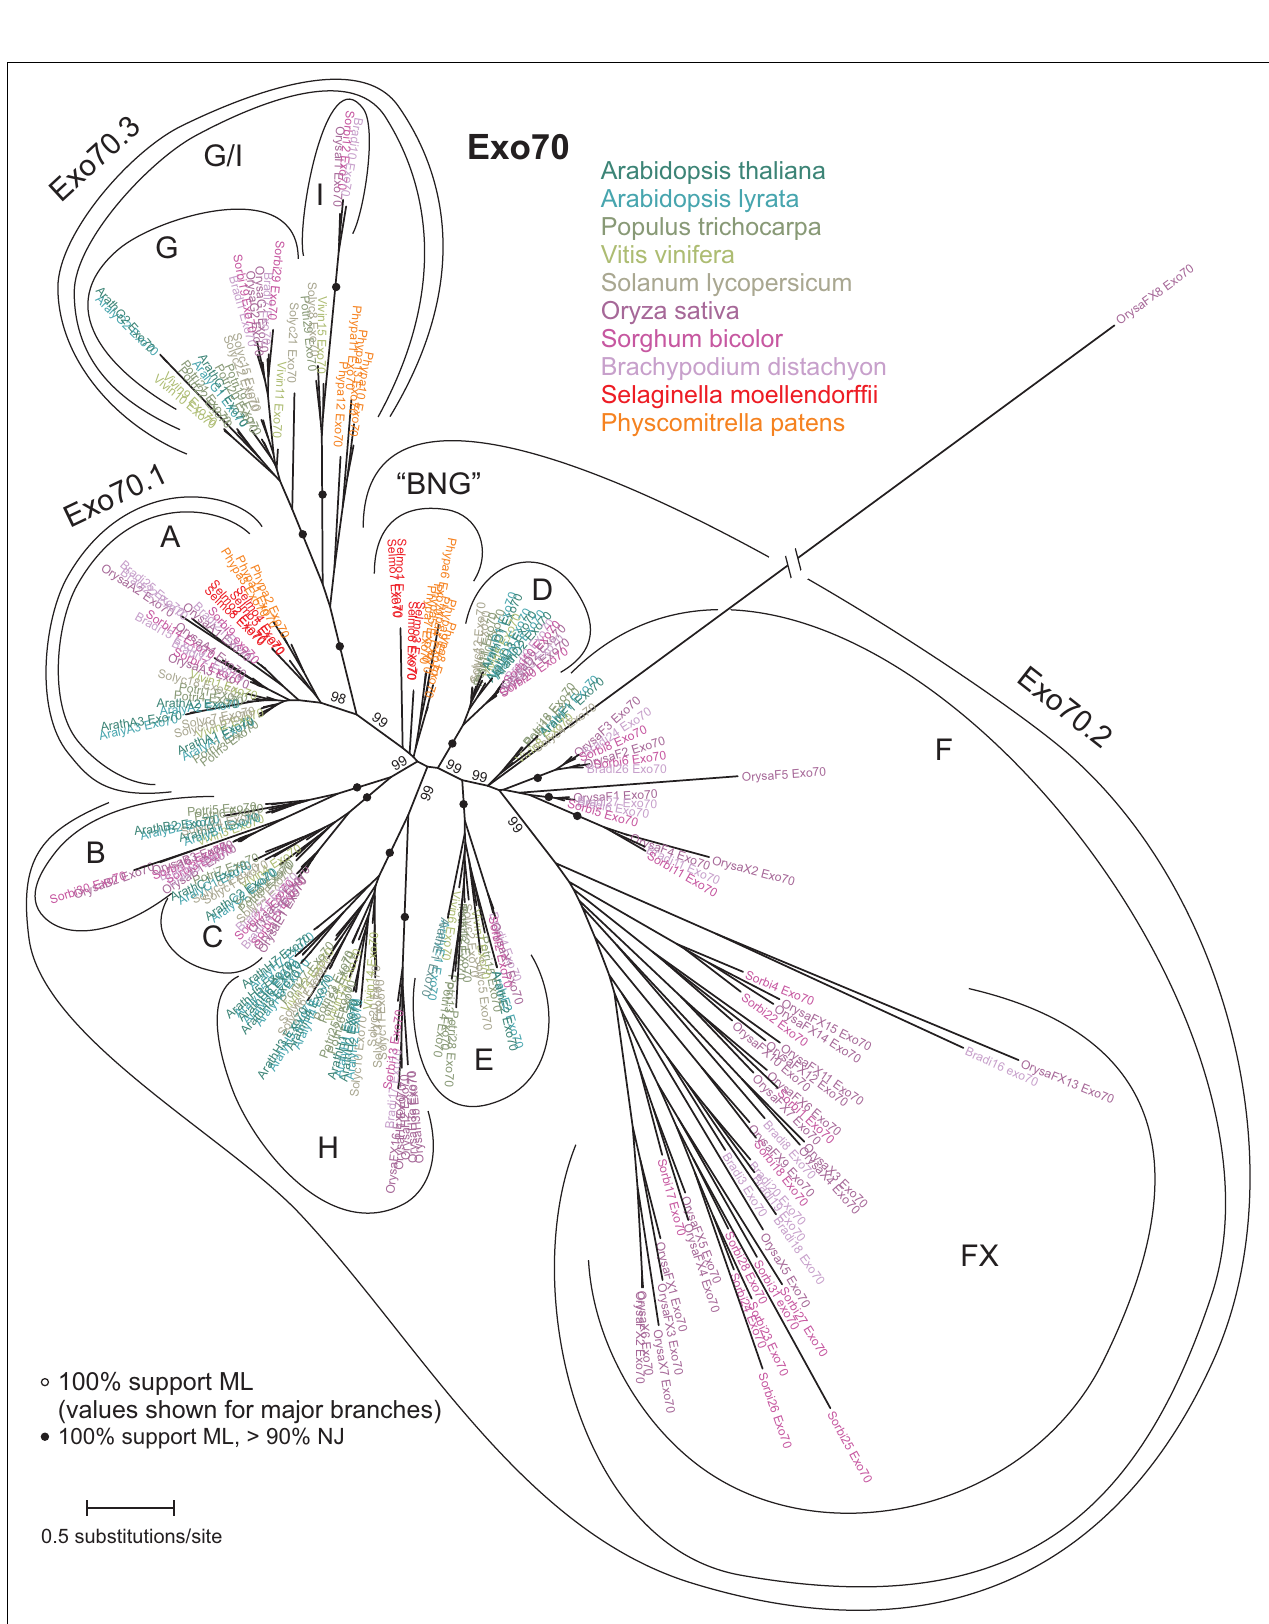
FIGURE 3 | Unrooted maximum likelihood (ML) phylogram of Exo70. SH-like support values above 50% are shown only for major branches for the sake of legibility. A tree obtained using the neighbor-joining (NJ) method was consistent with the ML one except of placing the FX branch outside the F clade; nodes with high support by both ML and NJ algorithms are marked by black dots. “BNG” denotes the basal non-angiosperm group of Exo70 paralogs.